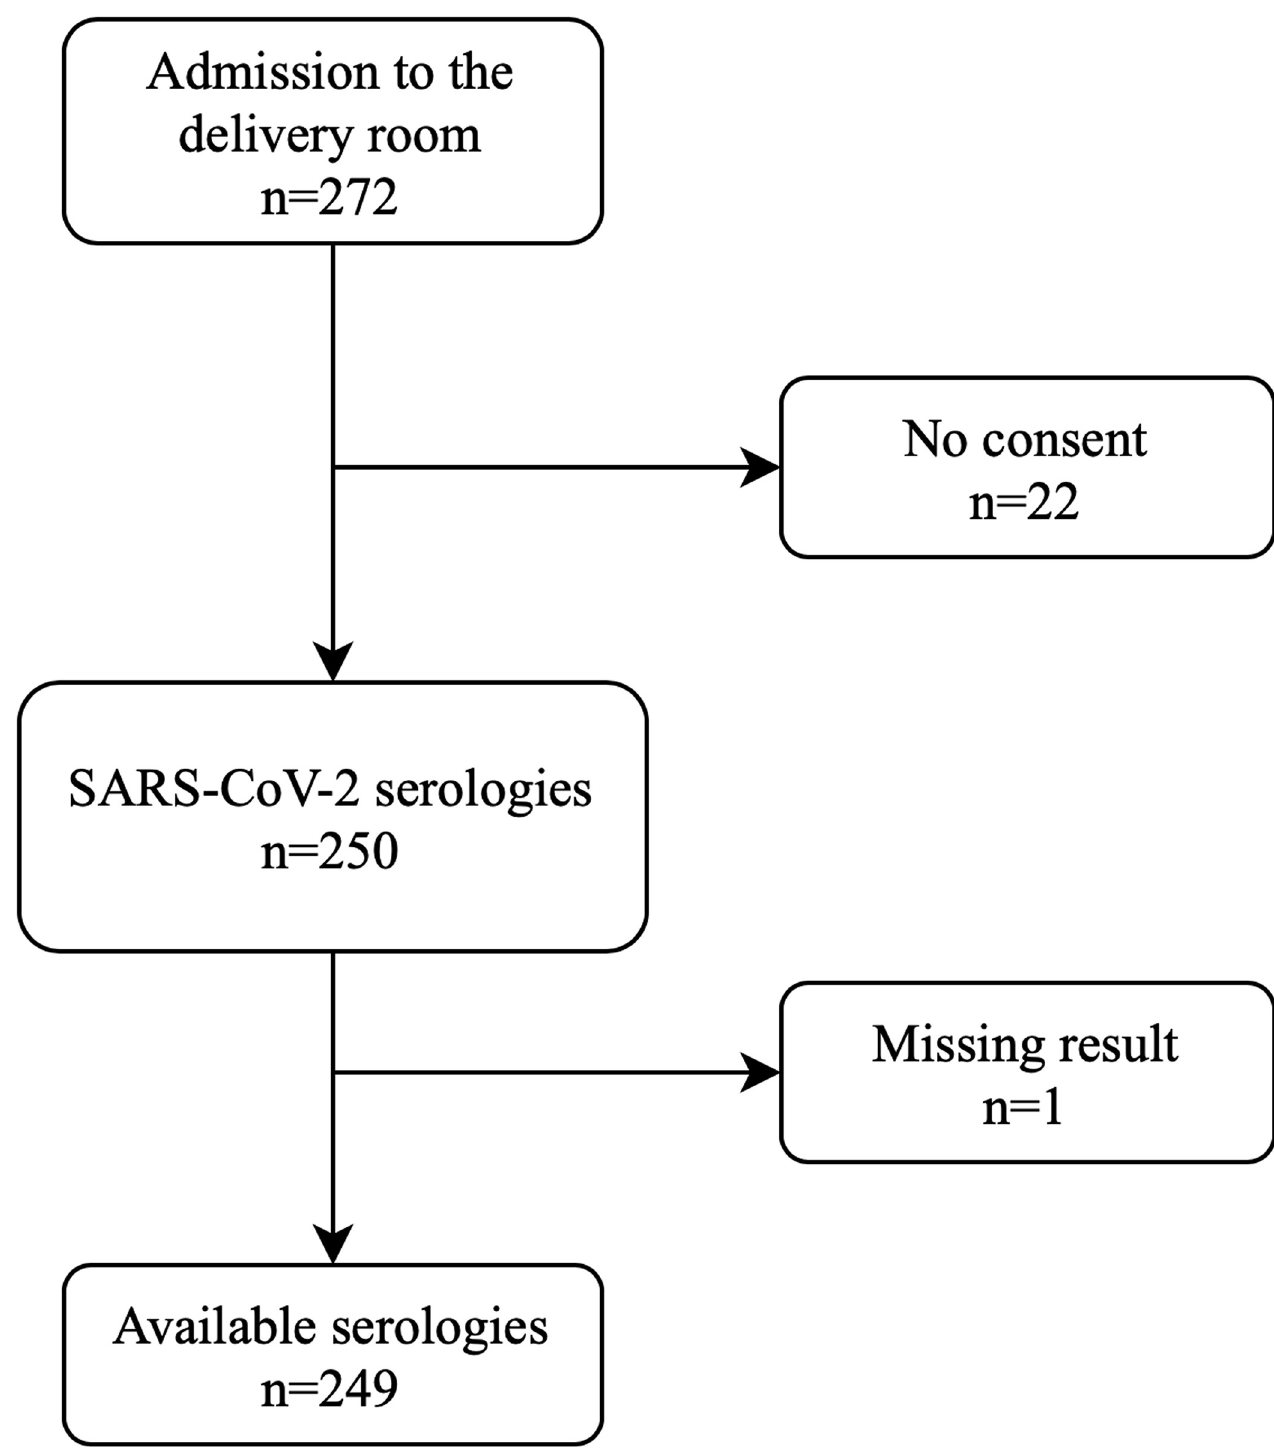
Fig 1. Flow chart of the study–universal serology screening for SARS-CoV-2 among a cohort of women admitted for delivery.